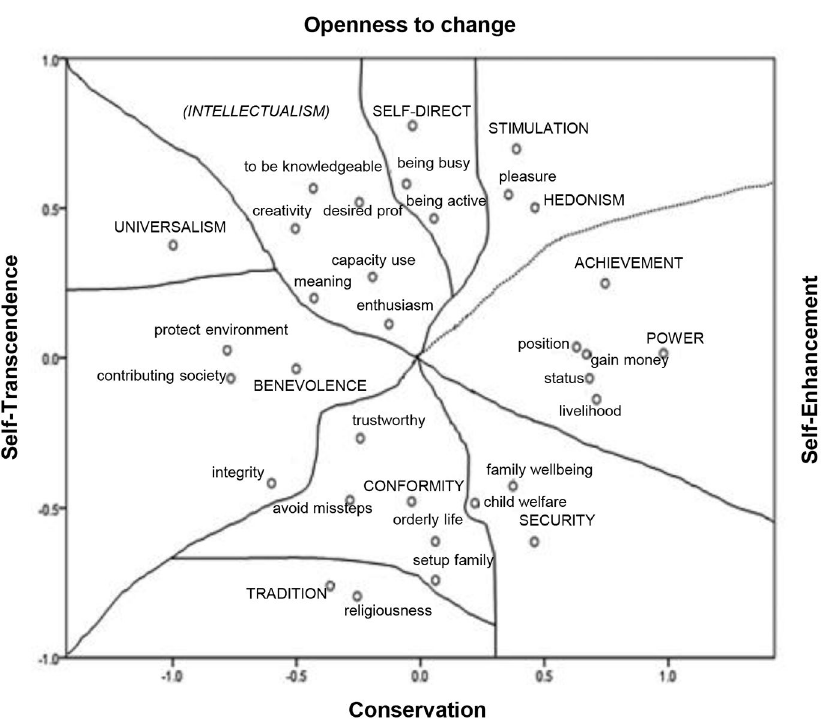
Figure 1. Configuration derived from the combination of WAG and PVQ items (Tevrüz, Turgut, & Çinko, 2015). Personality Profile Scale